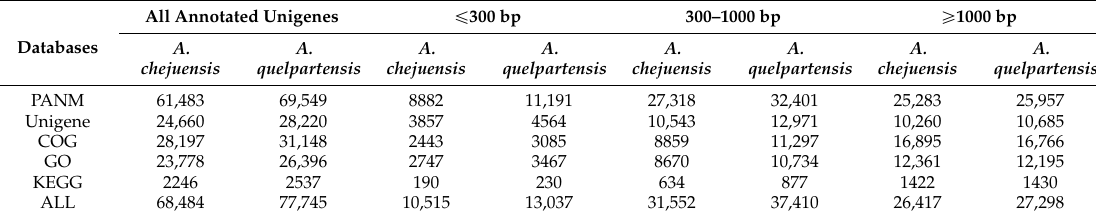
Table 2. Annotation of A. chejuensis and A. quelpartensis unigenes against the public